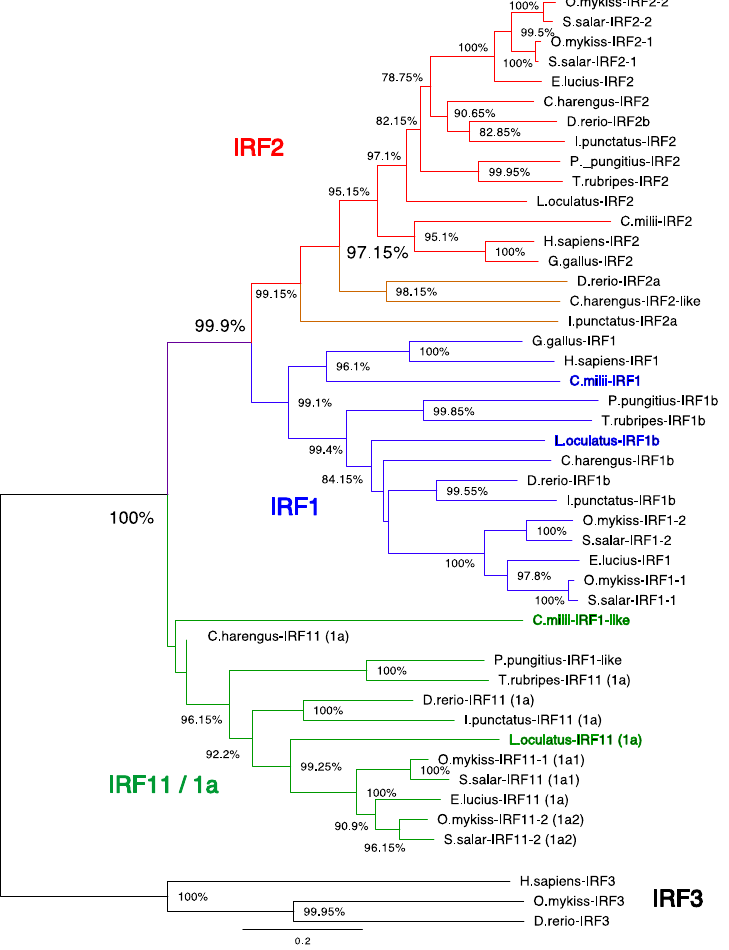
Figure 3. Phylogenetic tree showing the evolutionary relationship of IRF1 and IRF2 transcription factors in vertebrates with IRF3 used as an outgroup. IRF protein sequences were aligned using ClustalW in the MEGA X software. Following alignment, the phylogenetic tree was constructed using the neighbour-joining method in MEGA X and corrected using the Poisson model. The branch support values were gained by non-parametric bootstrapping (2000 replicates). The scale bar represents the calculated evolutionary distance. Genbank accession numbers for all species can be viewed in Table S1.